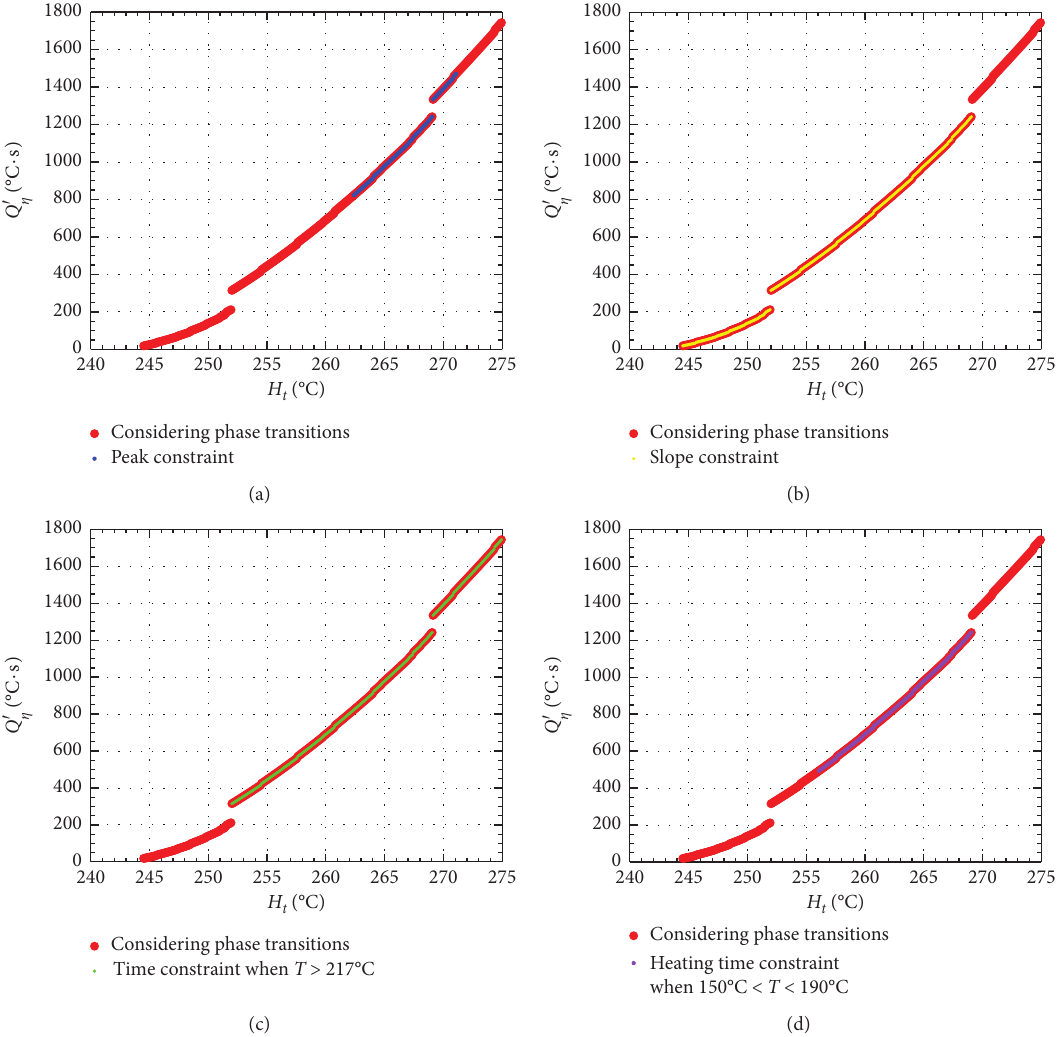
Figure 11: Effects of four process constraints in the range of | Δ H T > 217 ∘ C, and (d) heating time limiting when 150 ∘ C < T < 190 ∘